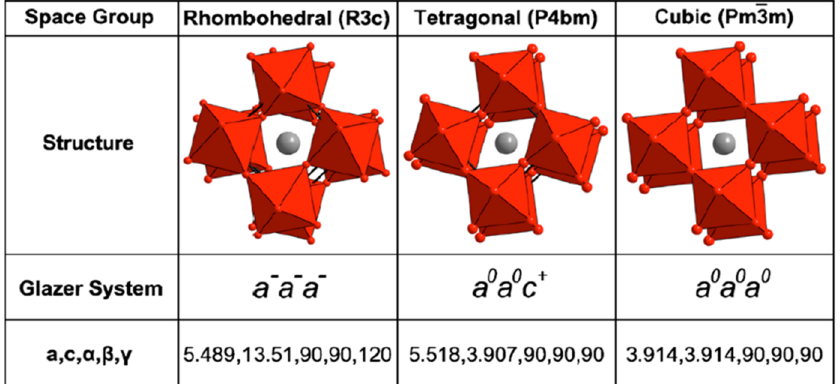
Figure 1. Structural properties of the rhombohedral R 3 c , tetragonal P 4 bm , and cubic Pm ‐ 3 m phases reported for Bi 0.5 Na 0.5 TiO 3 (BNT). The lattice parameters for the rhombohedral case are given in the hexagonal system. Reproduced with permission from [5].